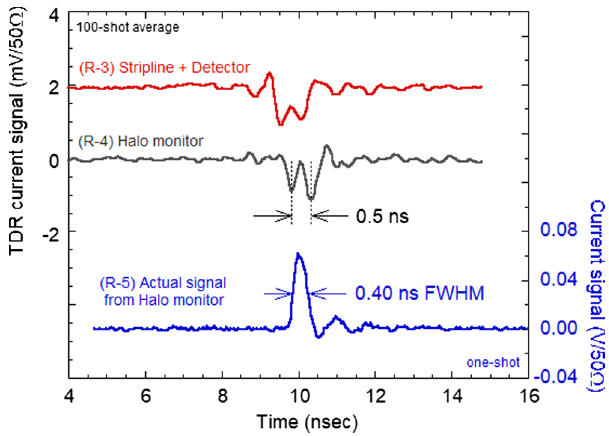
FIG. 8. Time structure of TDR signals and actual signal of electron beam halo monitor.